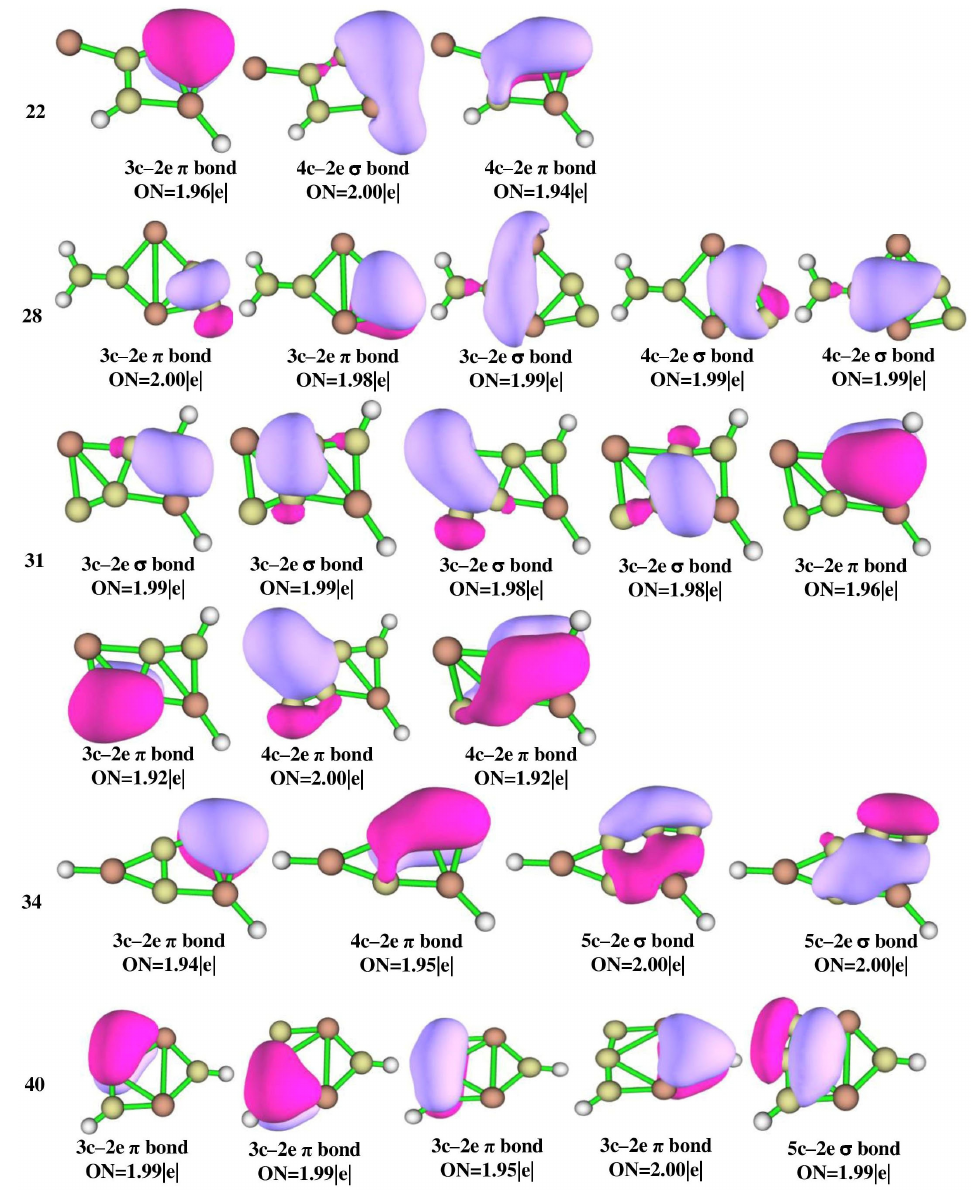
Figure 6. AdNDP bonding patterns of Al 2 C 4 H 2 isomers 3 , 4 , 14 , 18 , 20 , 21 , 22 , 28 , 31 , 34 , and 40 at the ω B97XD/6 ‐ 311++G(2d,2p) level of theory.